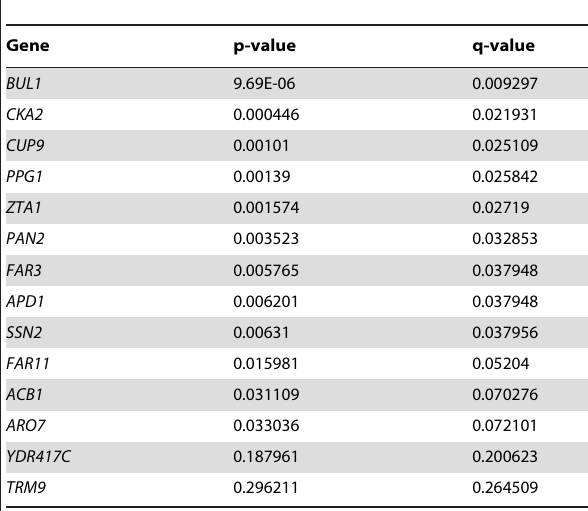
Table 1. Putative long-lived deletion mutants selected to confirm their long-lived phenotype.